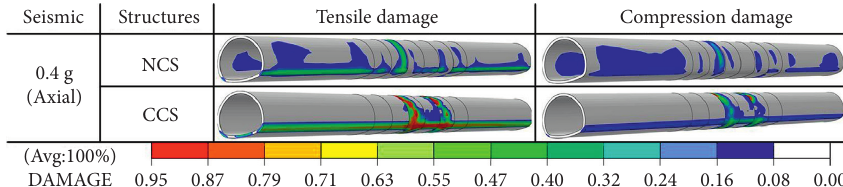
Figure 17: Cloud diagrams of the lining damage distribution under the axial